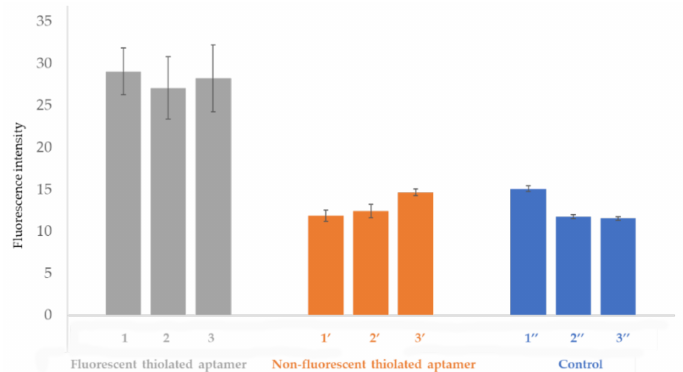
Figure 8. Fluorescence intensity of gold (AuNPs-2)-coated open OSTE-microchannels functionalized with fluorescent thiolated aptamers (channels 1, 2, and 3), non-fluorescent thiolated aptamer (channel 1 (cid:48) , 2 (cid:48) , and 3 (cid:48) ). As controls, microchannels (1 (cid:48)(cid:48) , 2 (cid:48)(cid:48) , and 3 (cid:48)(cid:48) ) were treated according to the same experimental process but only with droplets of sodium phosphate bu ff er (pH 8, IS = 50 mM) + 5 mM MgCl 2 . Fluorescence intensities are presented after washing the microchannels (See experimental section for more details on experimental conditions and fluorescence measurement parameters). Error bars represent standard deviations for seven